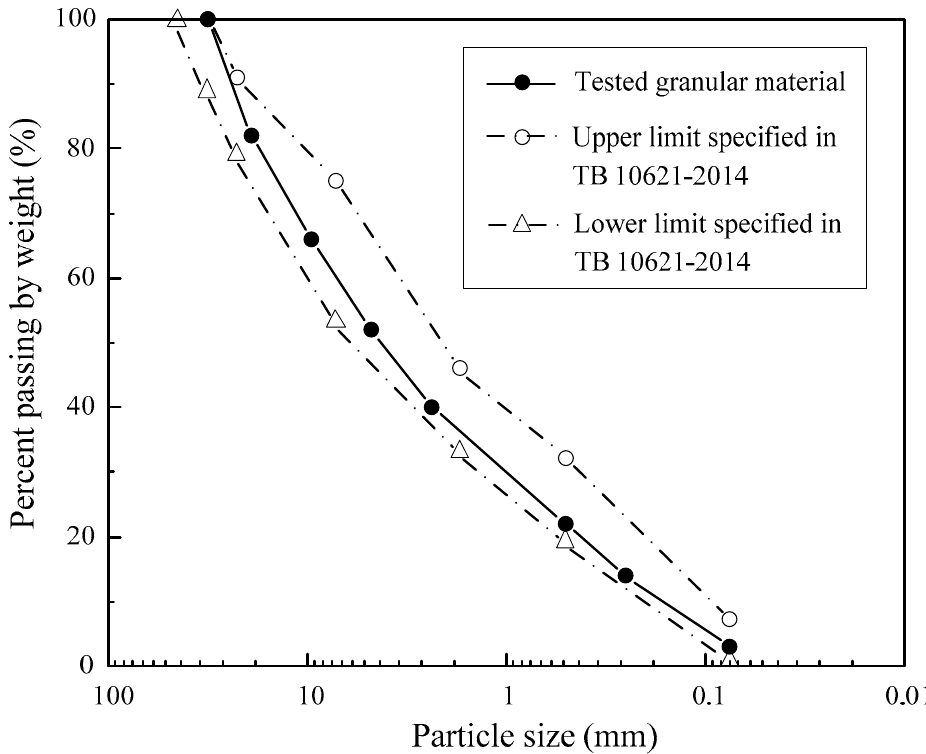
Figure 2. Grain size distribution of the graded gravel in this study.